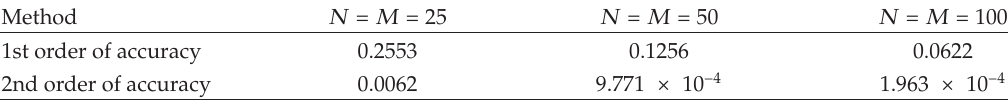
Table 1: Error analysis of first and second order of accuracy di ff erence schemes for Example 3.1.